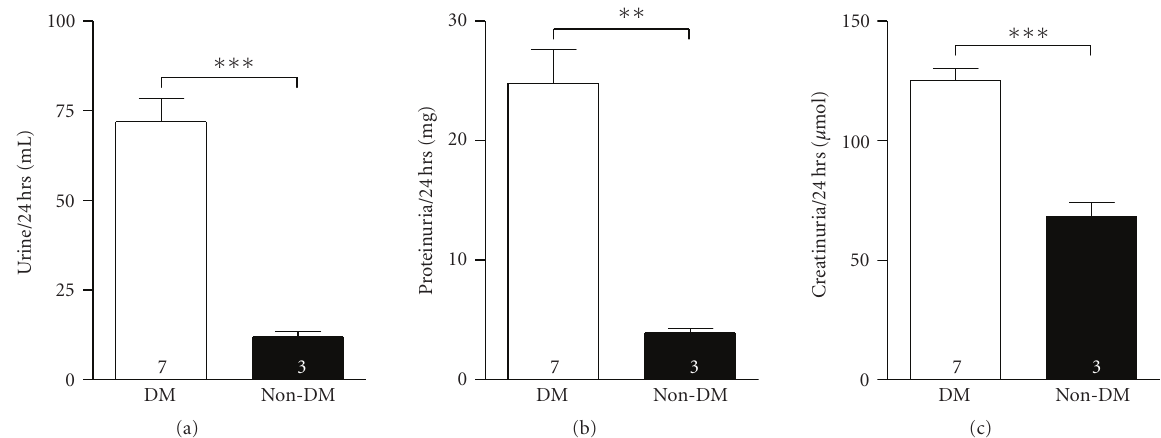
Figure 3: Long-term diabetes in BBDP rats is associated with significant polyuria (a), proteinuria (b), and creatinuria (c). Two weeks prior to stenting rats were housed in metabolic cages, and 24-hour urine samples were collected and analyzed as described in Section 2. Data are expressed as mean ± SEM ( ∗∗ P < . 01, ∗∗∗ P < . 001). Values within bars indicate the number of rats analyzed. DM: long-term diabetic BBDP rats, Non-DM: non-diabetic